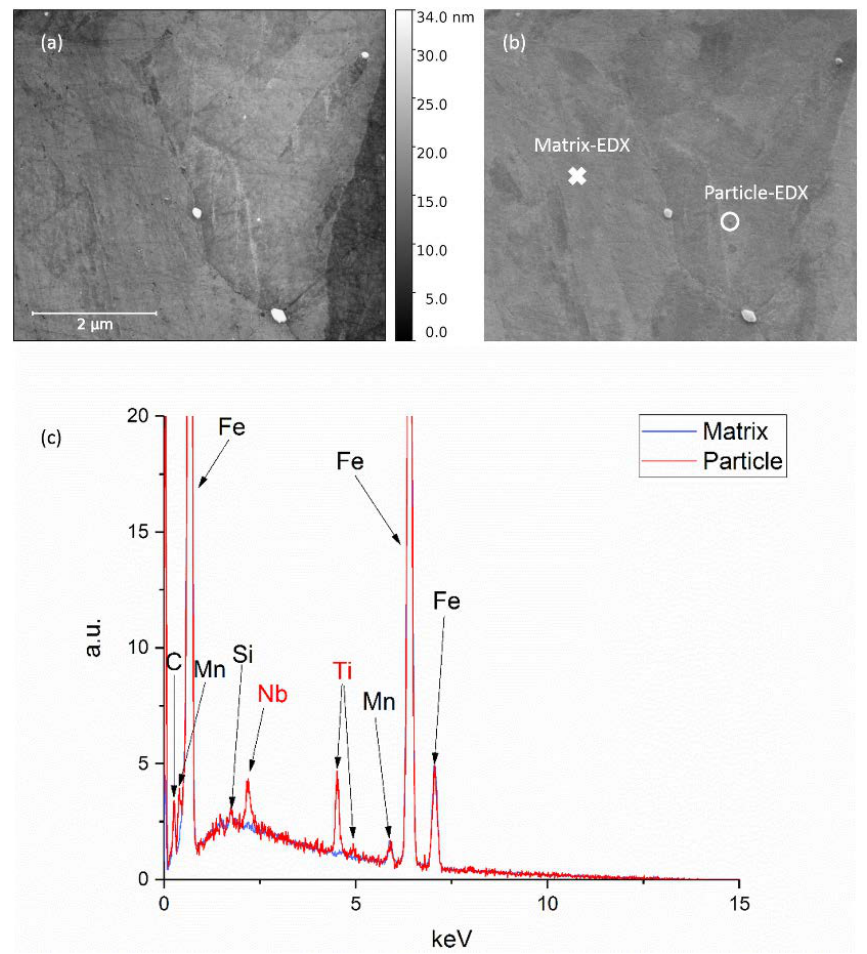
Figure 4. AFM map ( a ) and corresponding SE image ( b ); spectrum of the chemical analysis of the matrix ( c ) and one precipitate, which is shown for all other measured particles.